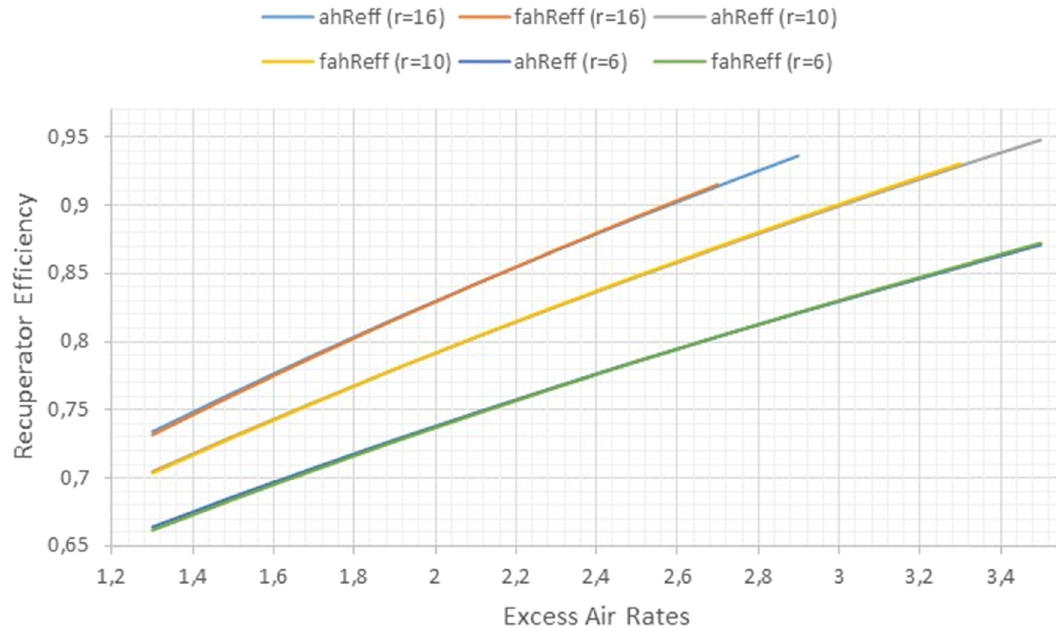
Figure 16: Variation of the recuperator e ffi ciency with excess air rates for di ff erent compression ratios of the ah and fah cogeneration